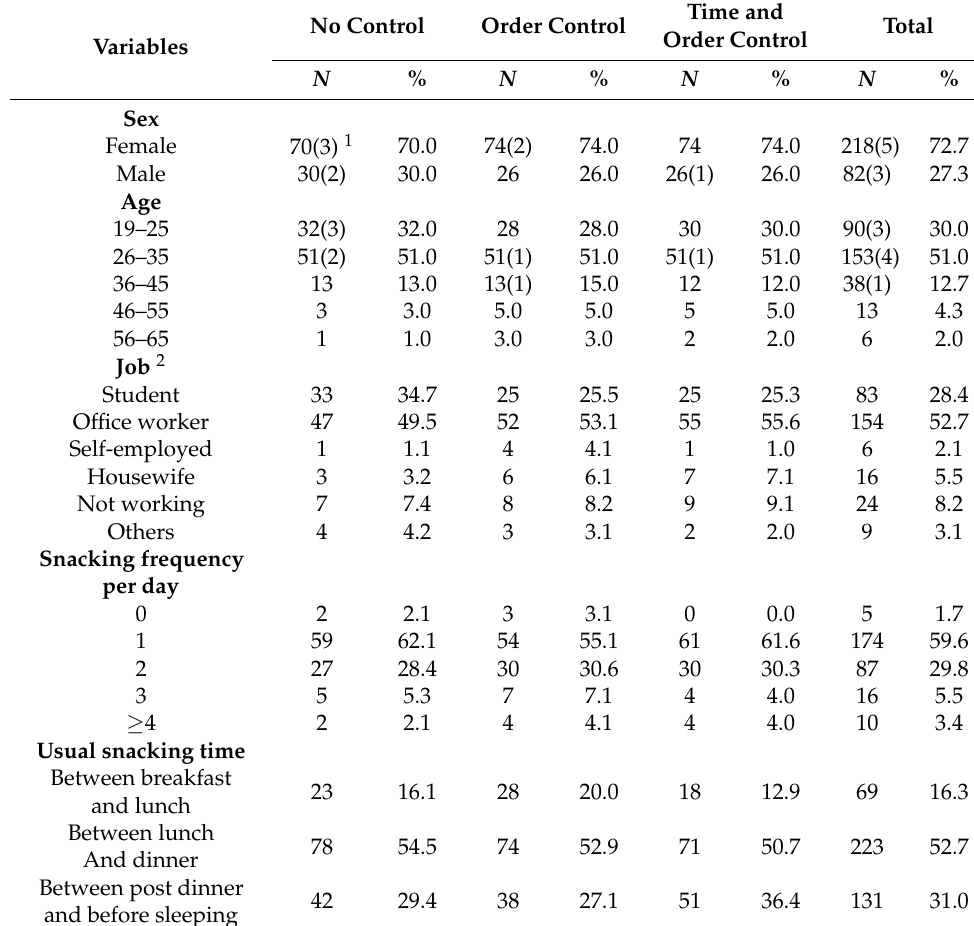
Table 1. Demographic information of the three groups of